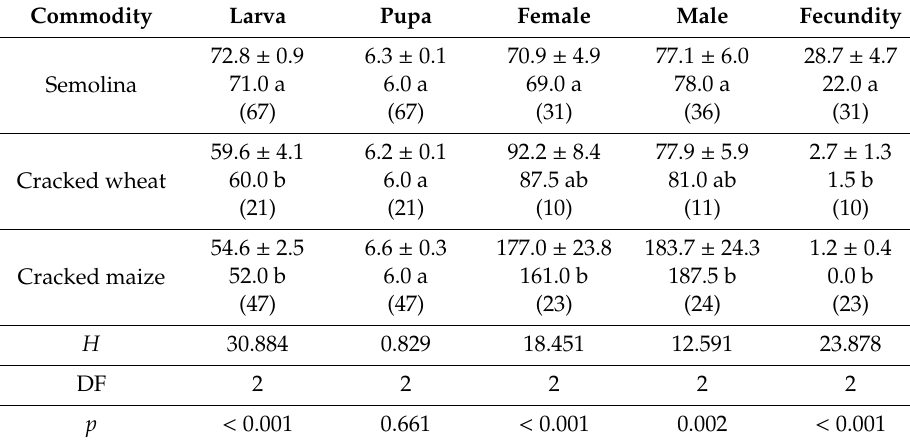
Table 1. Duration of immature development, female and male longevity in days (mean ± SE, median)